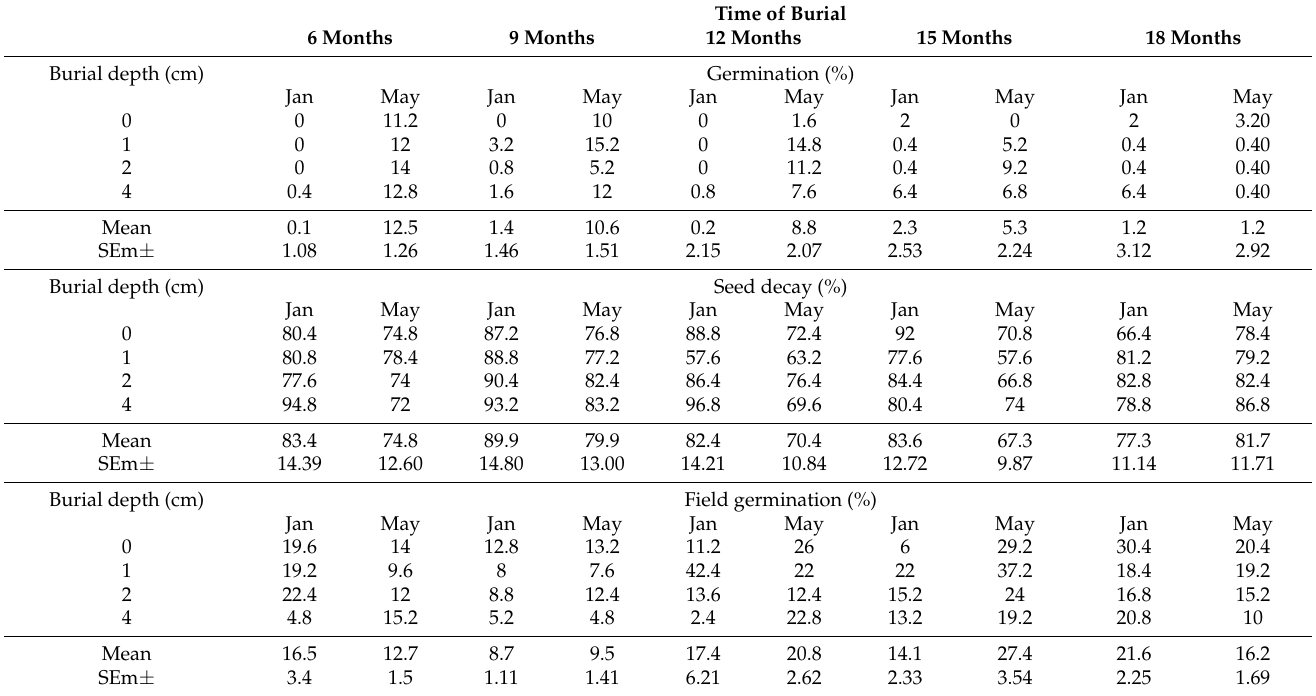
Table 2. Effect of burial depth and time on N. trichotoma seed persistence for seeds buried in January and